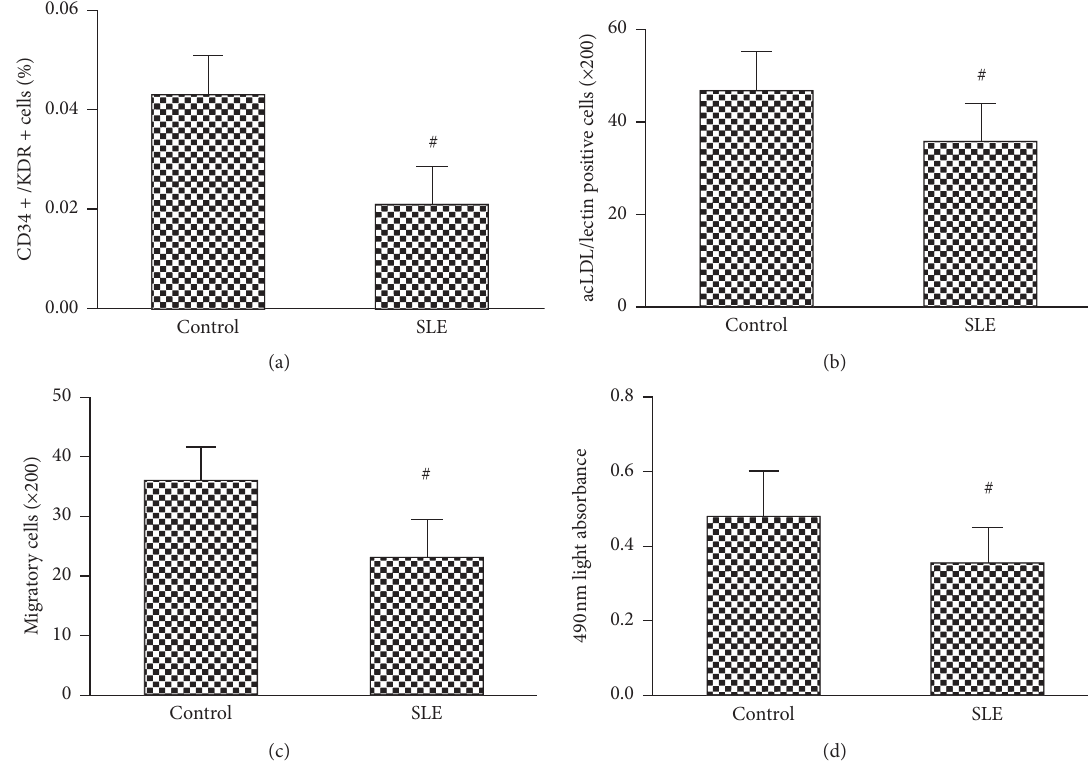
Figure 2: The number of circulating EPCs in the SLE patients and healthy controls. Evaluated by (a) FACS analysis and (b) phase-contrast fluorescent microscope, the number of circulating EPCs in SLE patients was lower than those in the control subjects. The migratory (c) and proliferative (d) activities of circulating EPCs in SLE patients were lower than those in the healthy control. Data are given as mean ± SD. # P < 0.05 vs. control